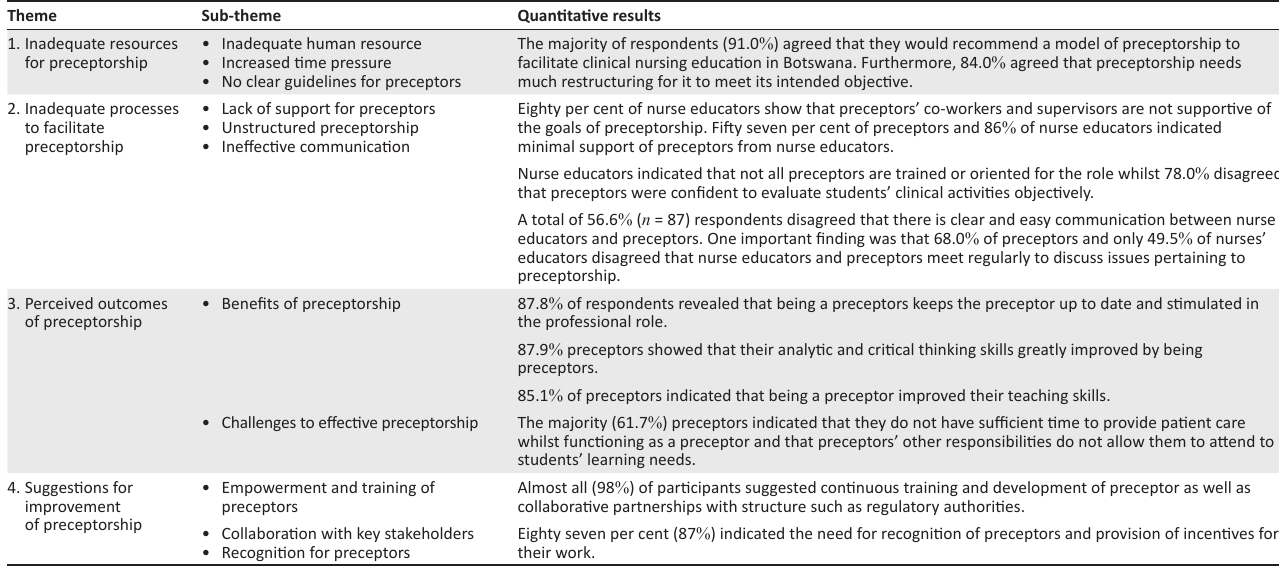
FIGURE 2: A precetorship model to facilitate clinical nursing education in Botswana. TABLE 1: Preceptors’ and nurse educators’ perceptions on